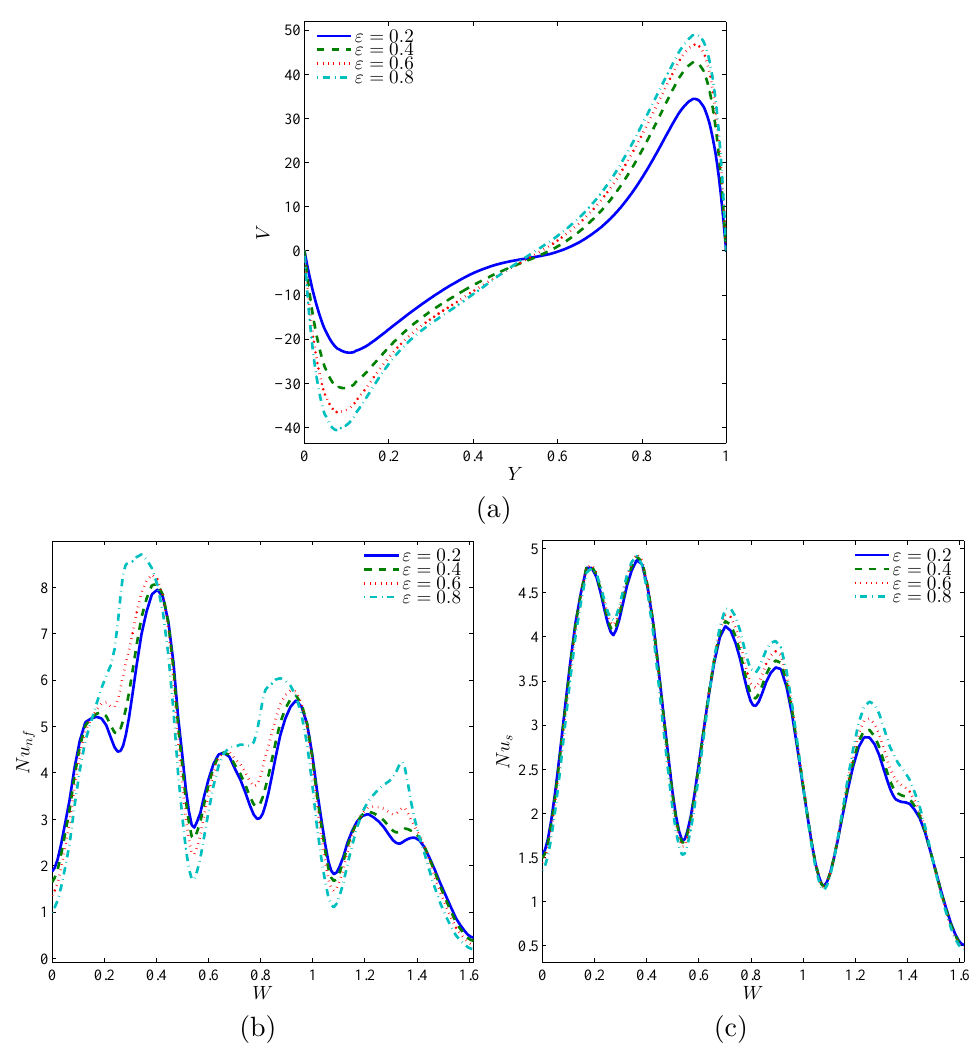
Figure 12. Local velocity ( a ), the local Nusselt number of the nanofluid phase ( b ), and the local Nusselt number of the solid phase ( c ) with the vertical line ( Y ) for X = 0.5 for different ε values; Da = 10 − 3 , φ = 0.02, γ = 10, and A =